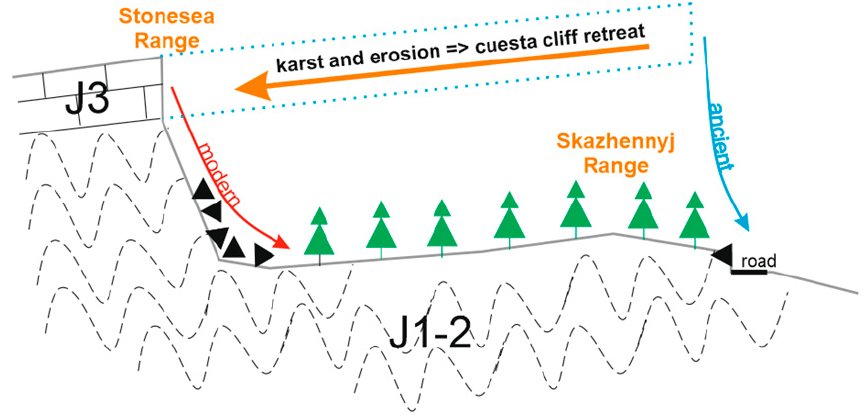
Figure 5. Conceptual explanation of the origin of the studied large clasts.